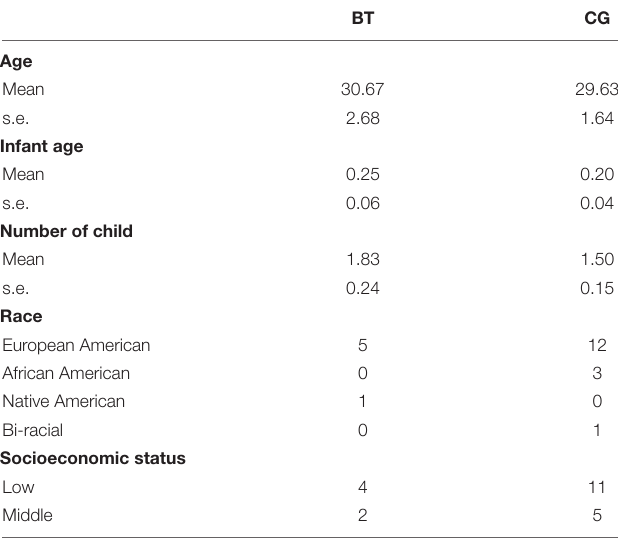
TABLE 1 | Demographics.